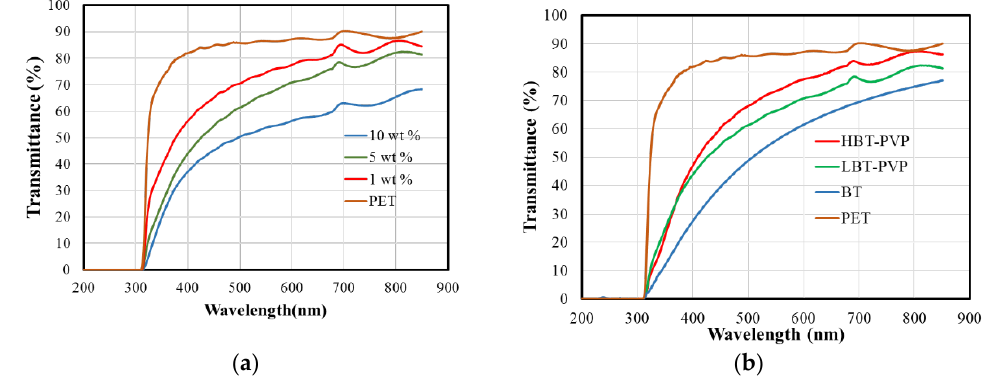
Figure 6. ( a ) Transmittance spectra of LBT-PVP films prepared in different concentration suspension